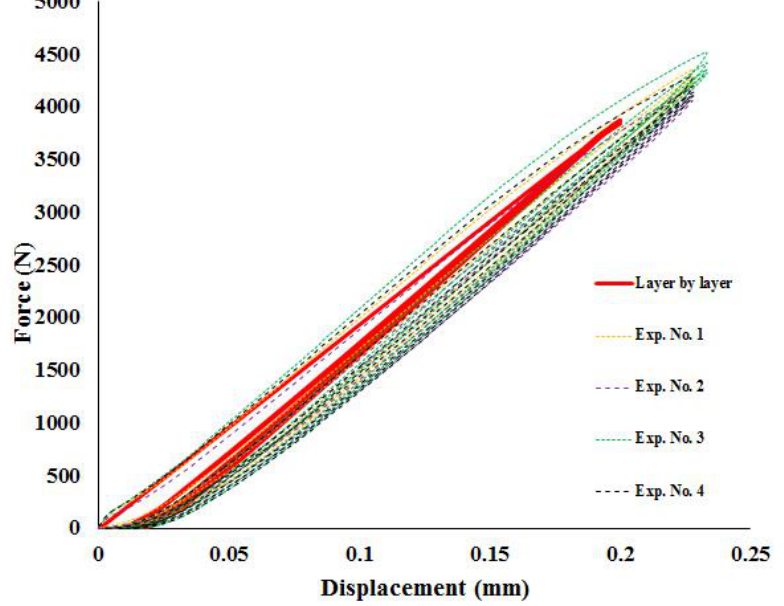
Figure 11. Compression force–displacement diagram and comparison between numerical simulation results (layer-by-layer) and experimental results (Exp. No. 1 – 4).